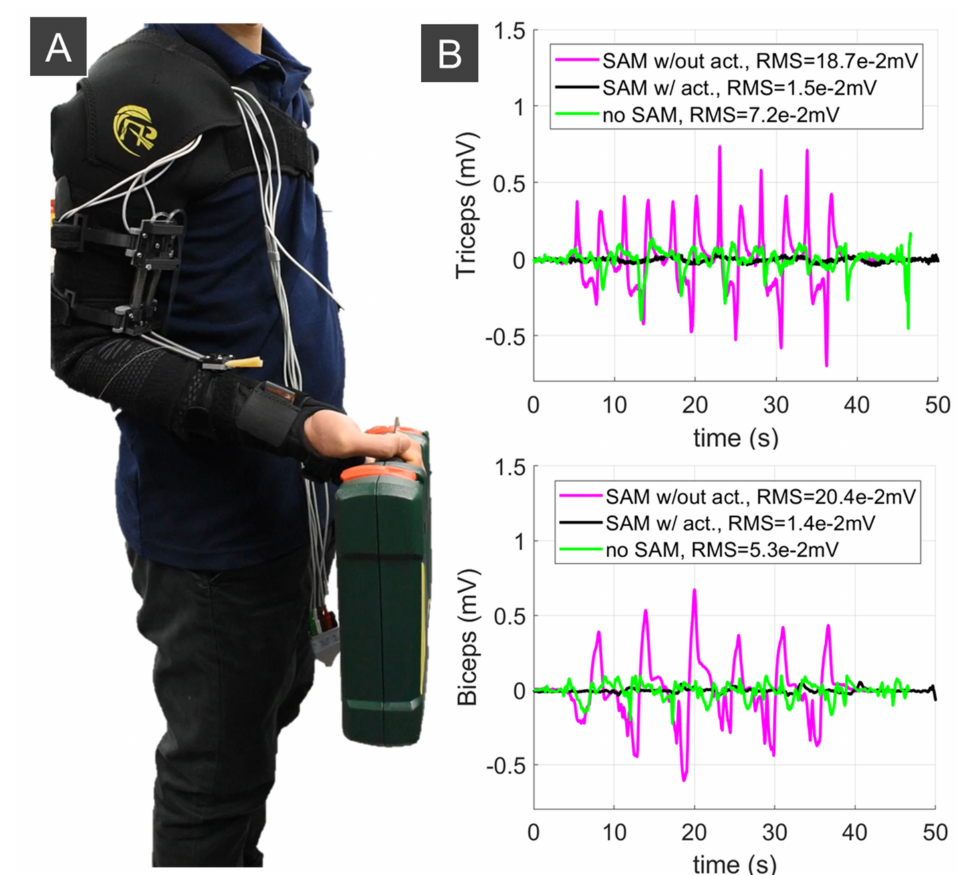
Figure 10. Validation of the soft robotic fabric sleeve for upper limb augmentation with EMG measurements and load of 1.8 kg. ( A ) Experimental setup for EMG measurements. ( B ) EMG